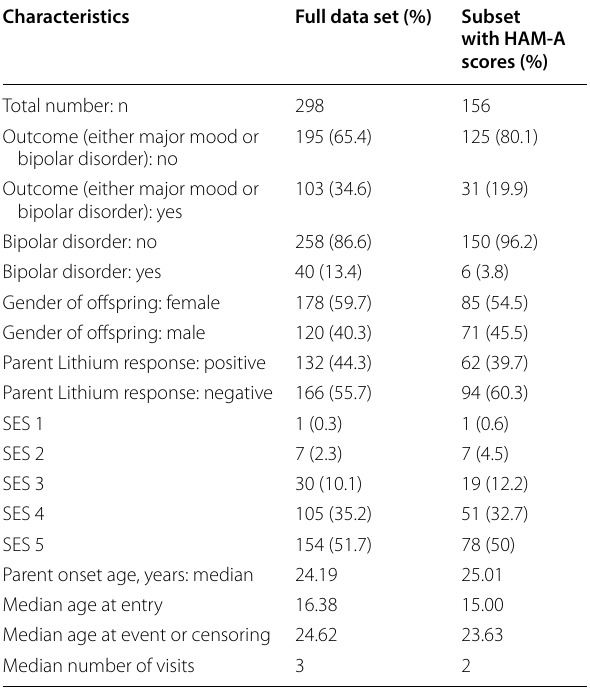
Table 1 Characteristics of offspring in the full dataset and the subset with HAM-A scores